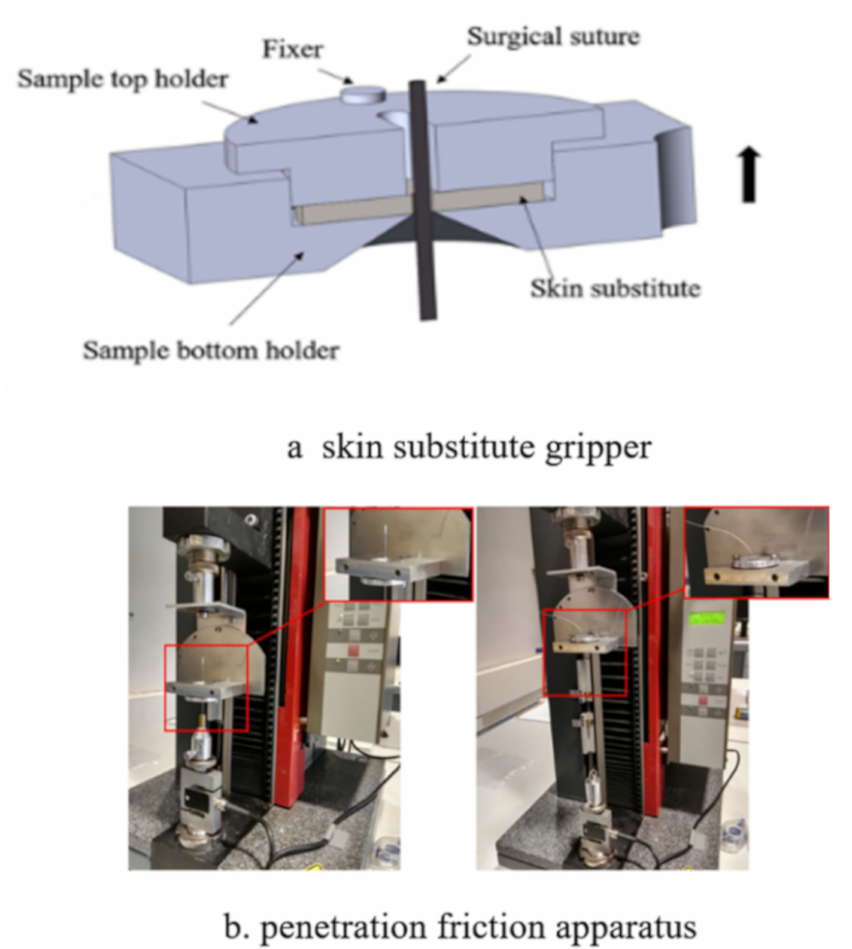
Figure 2. Penetration friction apparatus (PFA): ( a ) Skin substitute gripper; ( b ) penetration friction